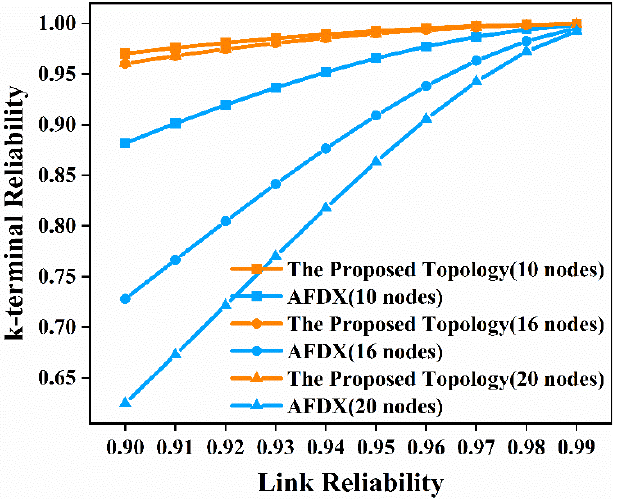
Figure 9. Time ‐ independent, k ‐ terminal reliability comparison diagram of the proposed topology Figure 9. Time-independent, k-terminal reliability comparison diagram of the proposed topology and AFDX in the three scenarios. and AFDX in the three